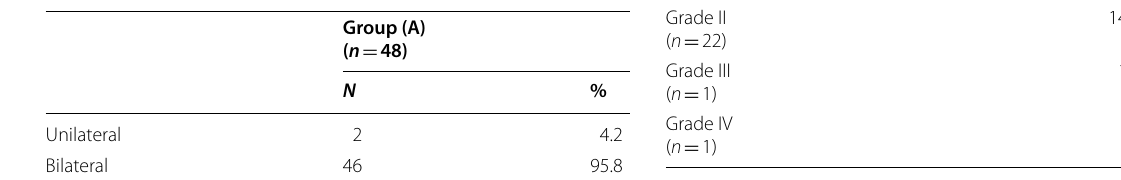
Table 4 Papilledema laterality among group (A)